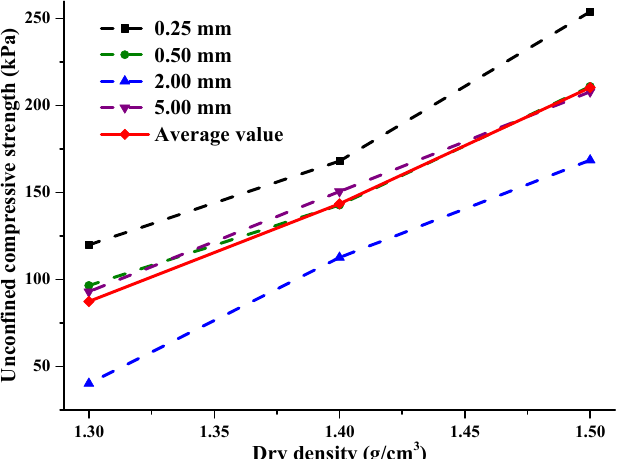
Figure 9. The fitting curve of dry density and UCS at different particle sizes.